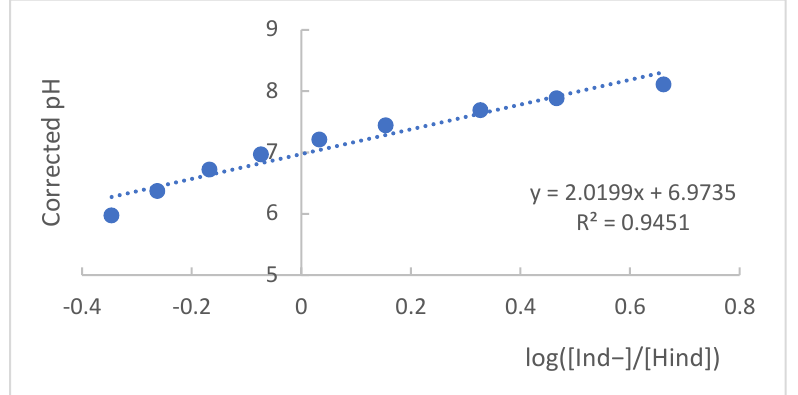
Figure 5. Graphical representation of pH values as a function of log value ([Ind−]/[Hind]) . Starting from Equation (2) and graphically representing the corrected pH values as a [ Ind − ] function of the values of log , as shown in Figure 5, it was possible to find the value of [ Hind ] pKa from the intercept of the curve with the Y-axis, a situation in which pH = pKa, which, for the methyl red indicator, is equal to 6.98.